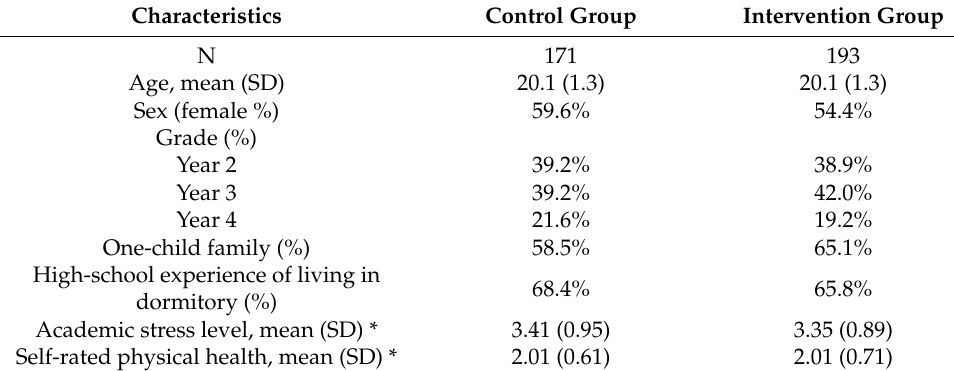
Table 1. Description of participant